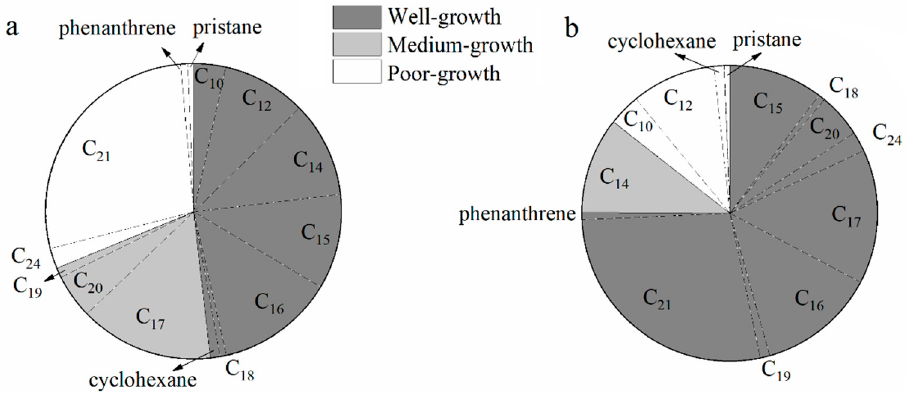
Figure 3. Growth characteristics of Kp ( a ) and Pa ( b ) cultivated with diesel constituents as a sole carbon source. Dark grey, light grey and white areas indicate good-growth (OD600 ≥ 1), medium-growth (0.4 < OD600 < 1) and poor-growth (OD600 ≤ 0.4), respectively.